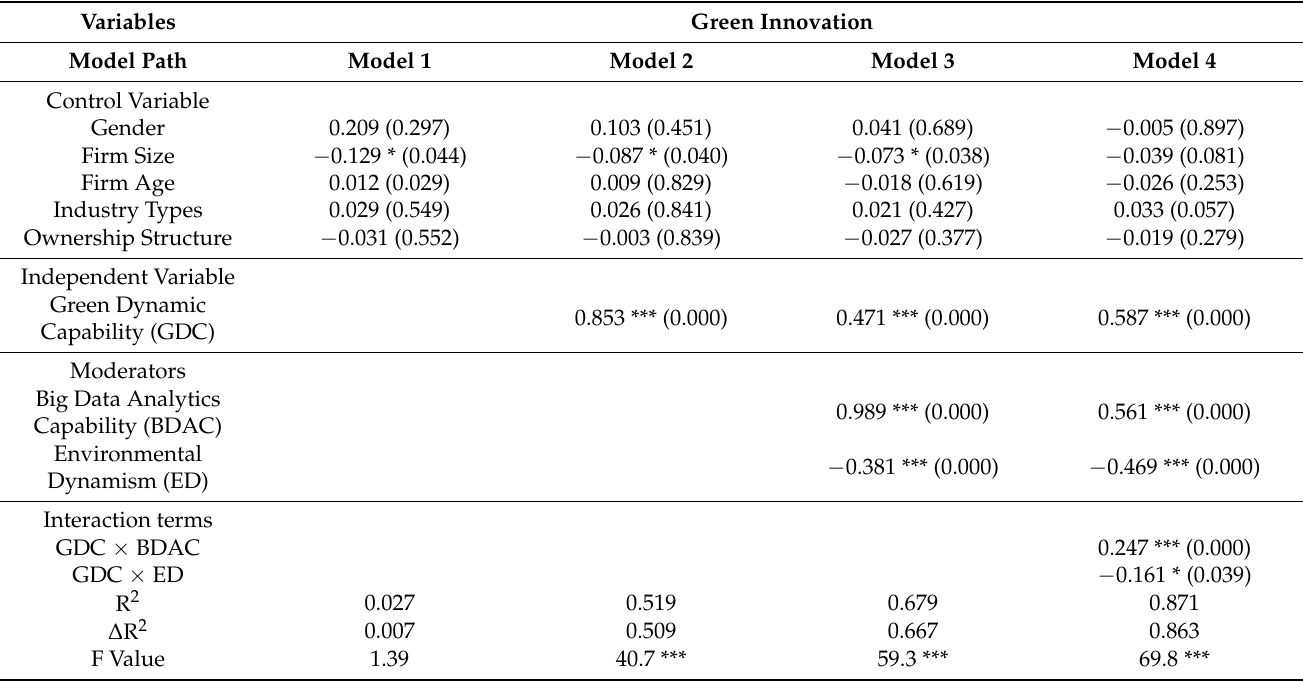
Table 7. Malaysian SMEs Hierarchical Regression Analysis